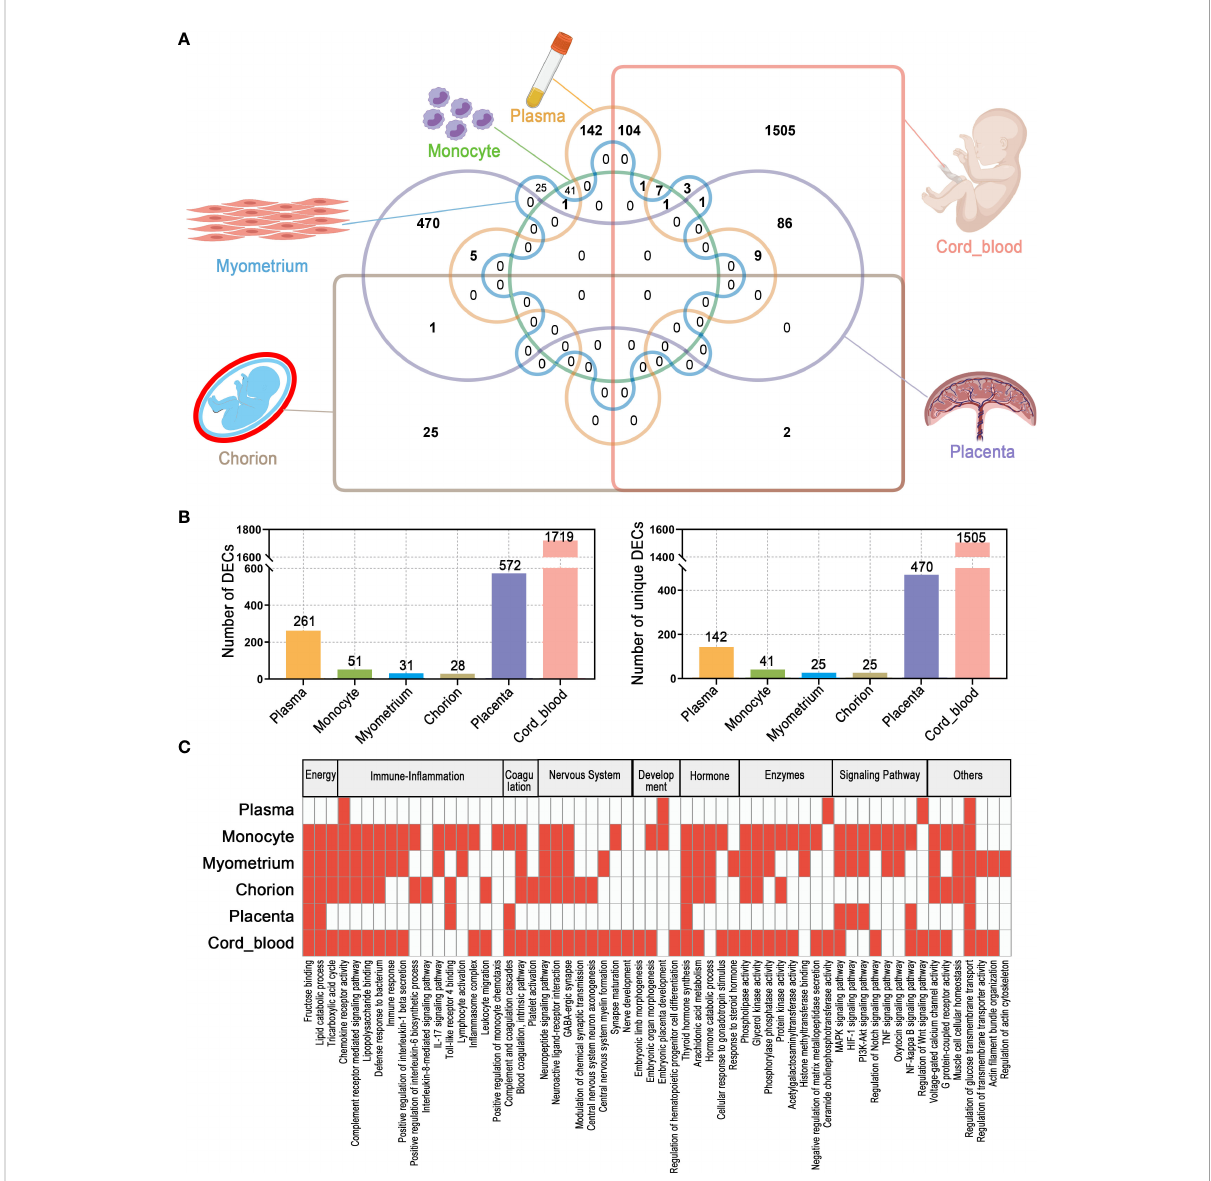
FIGURE 8 The overall characteristics of DECs and their possible functions in multiple maternal-fetal tissues of PTB. (A) Venn diagram of DECs in different tissues. (B) The number of total DECs and unique DECs in different tissues. (C) Summary and comparison of potential biological functions of DECs among different